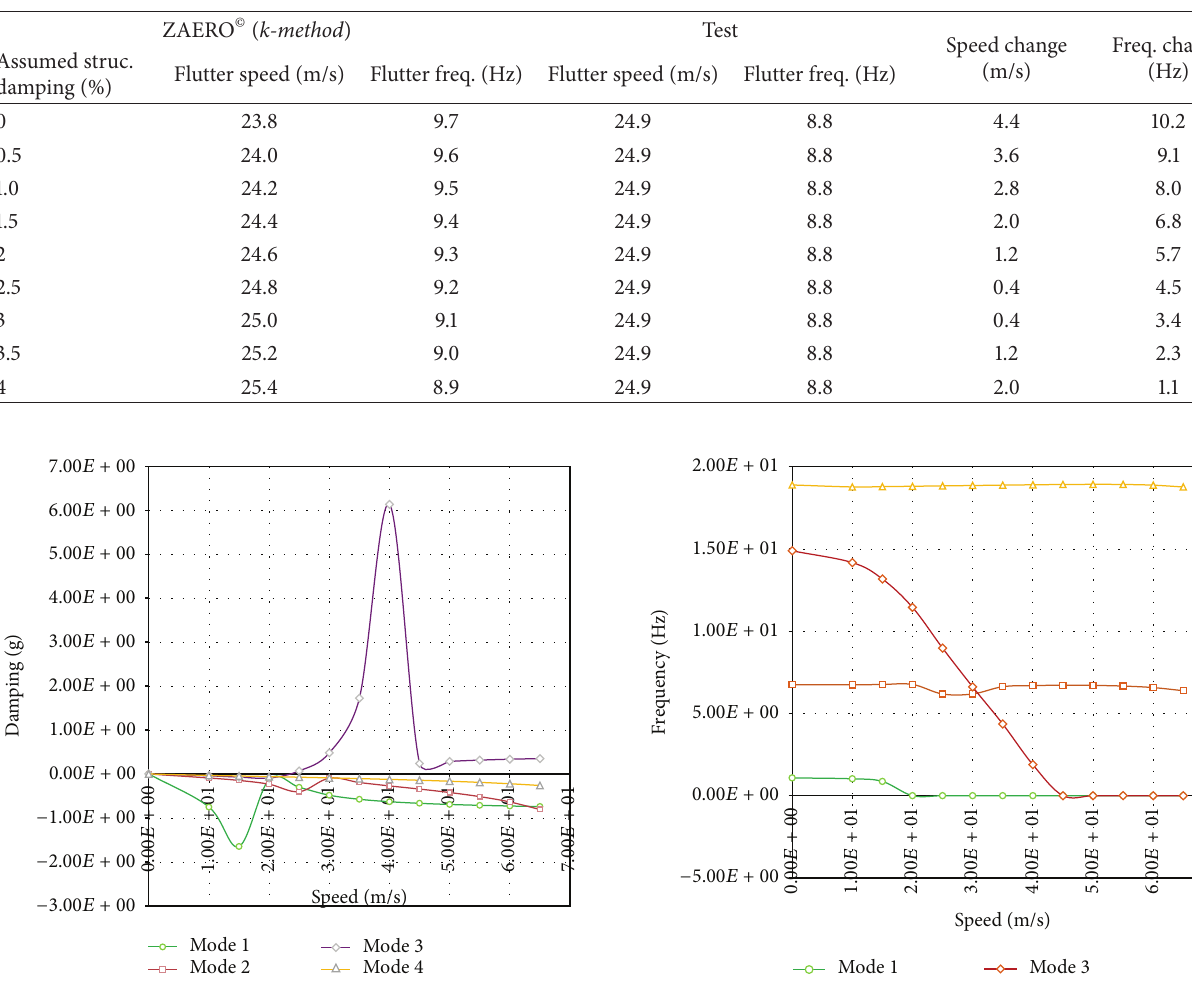
Speed change Freq. change (m/s)